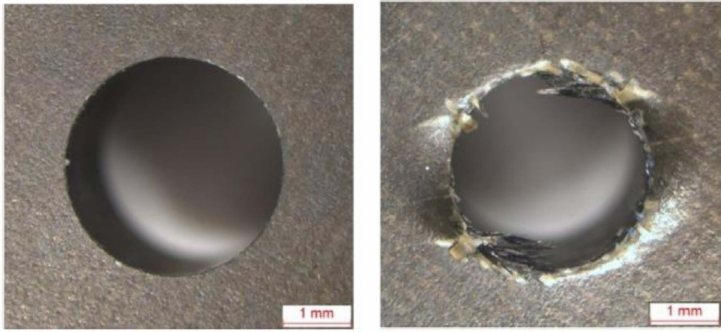
Figure 6. Comparison of the exit surface between holes made by a new (left) and a worn (right) tool with the same cutting parameters